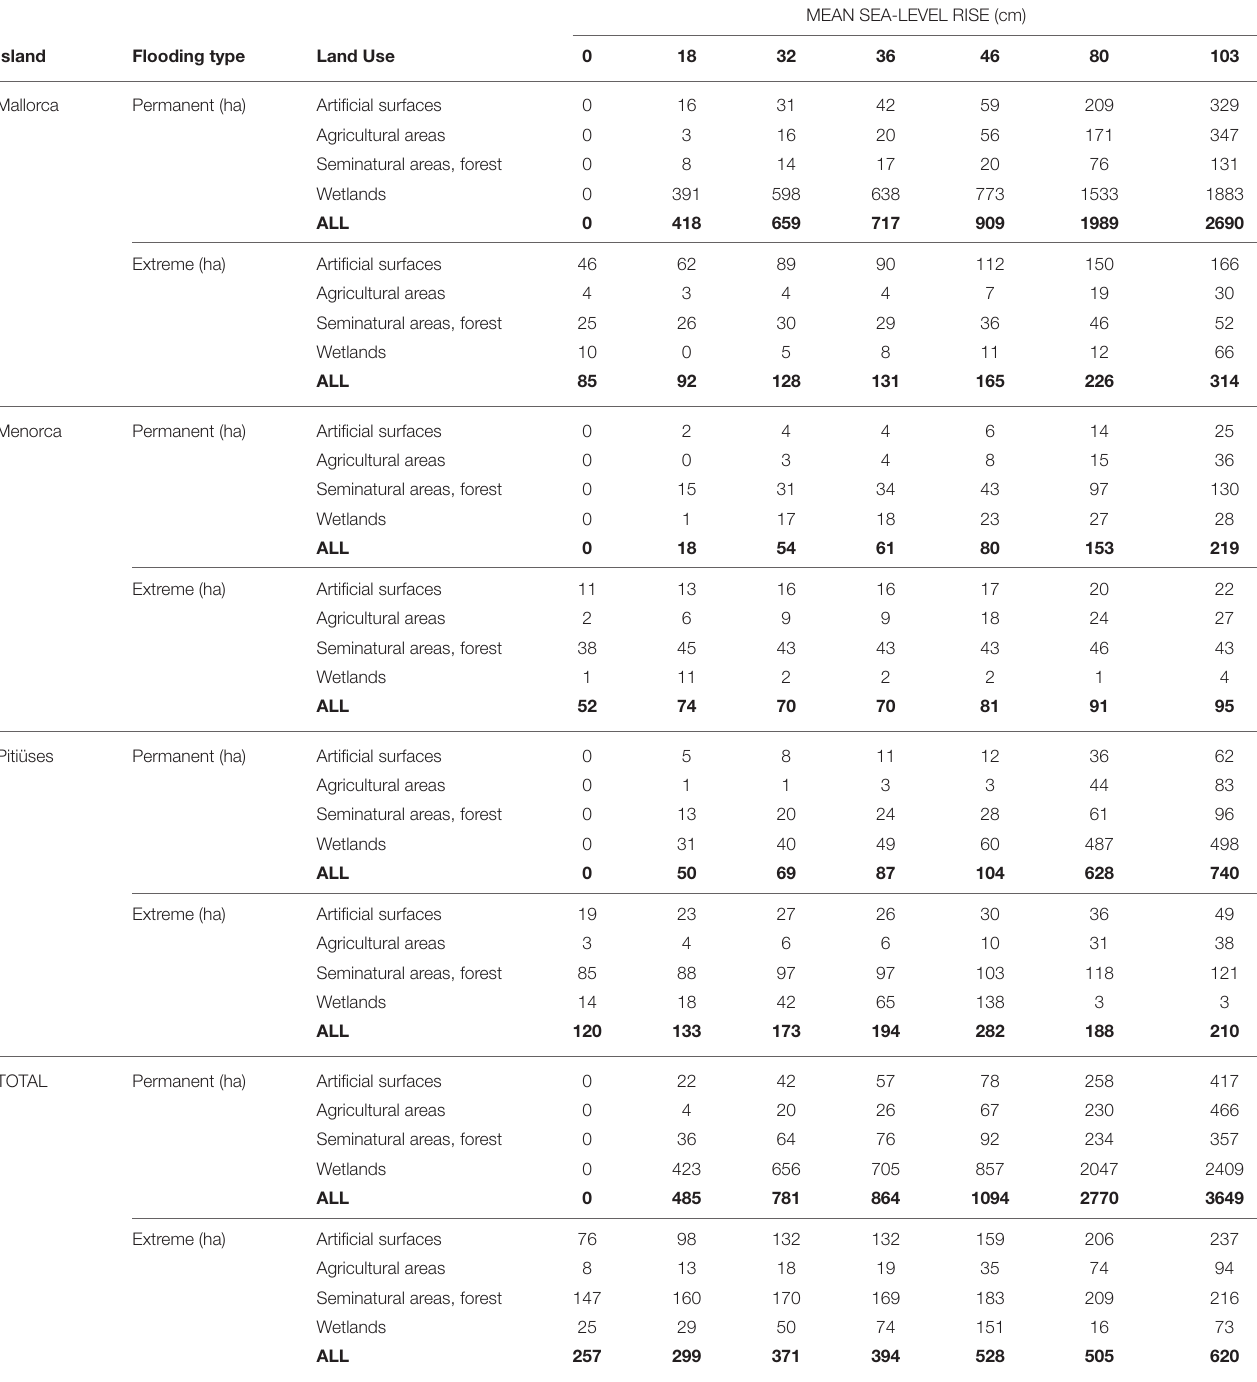
TABLE 2 | Coastal flooding extent (in hectares) resulting from the permanent and temporary flooding